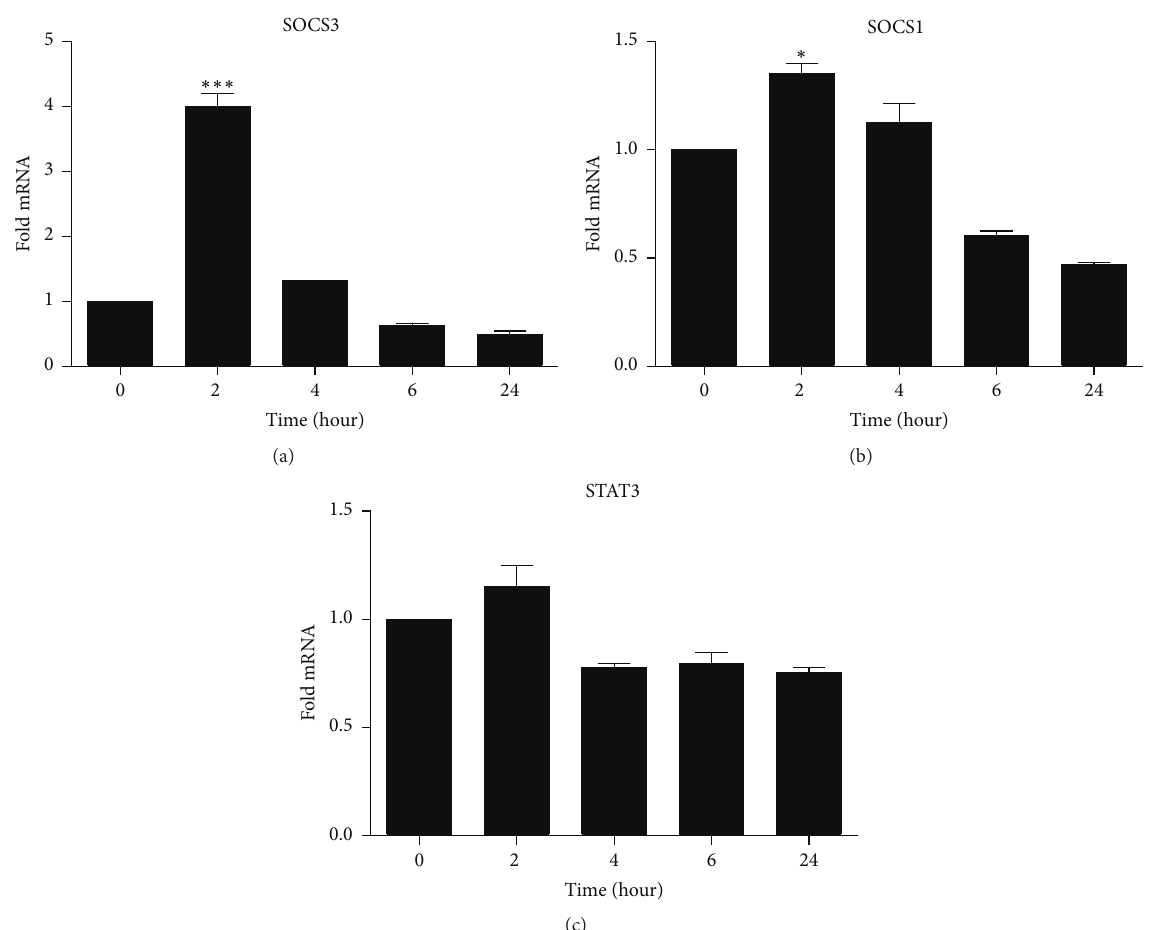
Figure 5: SOCS3 and SOCS1 increased in TPC-1cells treated with 15d-PGJ 2 . TPC-1cells were treated with 15d-PGJ 2 (9,8 𝜇 M) for 0 to 24 h. (a) shows the relative expression of SOCS3 (b), SOCS1 (c), and STAT3 (c) in the first two hours of treatment and decreased STAT3 four hours after the treatment (c). The date are presented as means ± standard deviation of three replicates from at least three independent tests. An asterisk ∗ indicates statistically significant difference from the control ( ∗ 𝑃 > 0.01 ; ∗∗∗ 𝑃 > 0.001